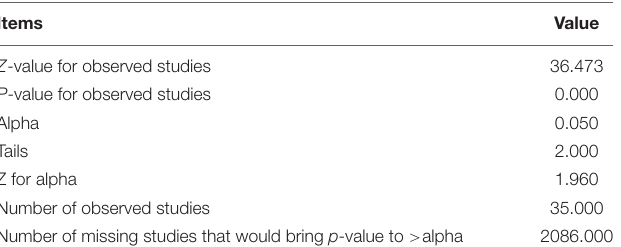
TABLE 2 | The analysis of classic fail-safe N